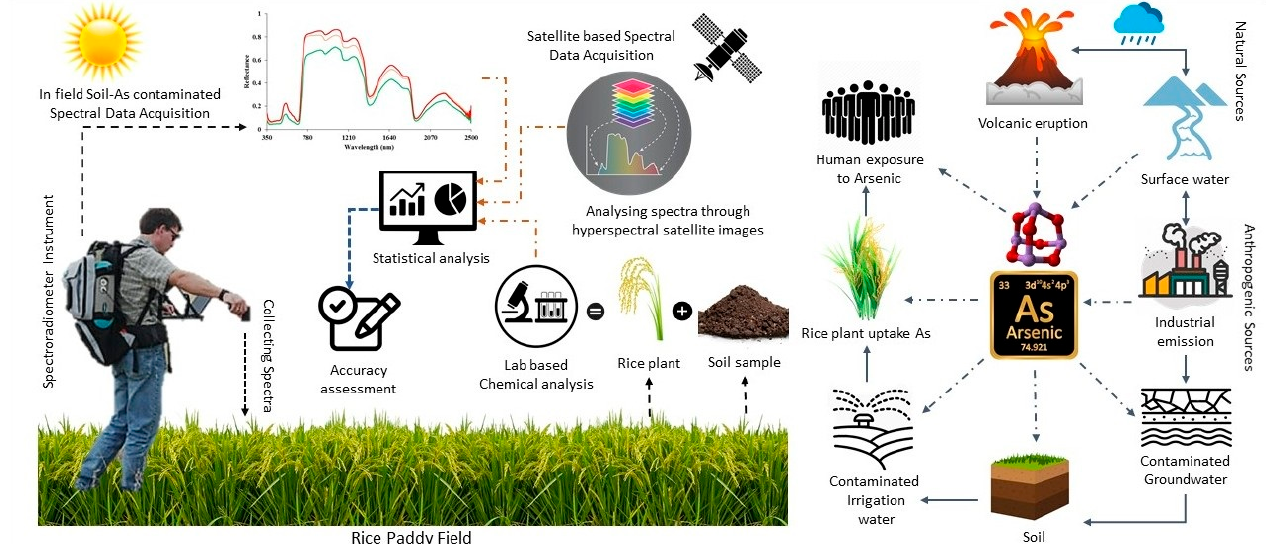
Figure 1. Arsenic cycle of environment and graphical methodology to identify the soil As concen- tration based on hyperspectral reflectance techniques.